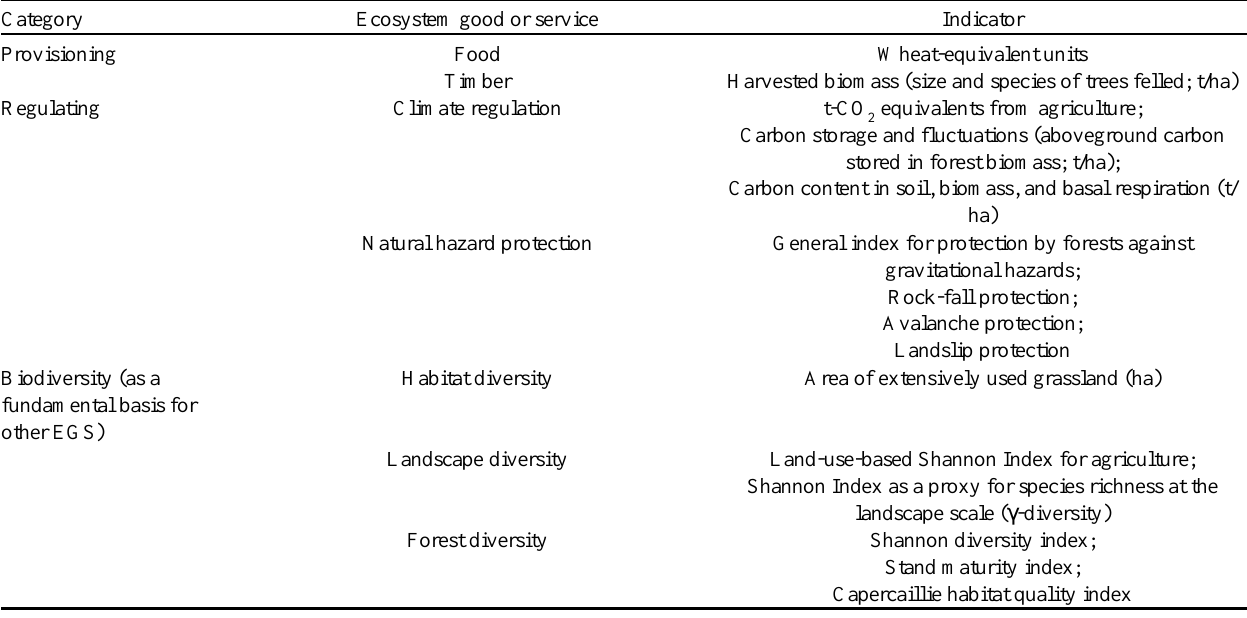
Table 1. Ecosystem goods and services considered in the Mountland